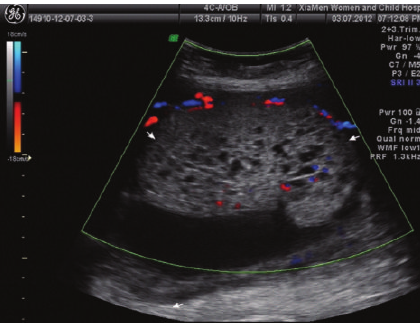
Figure 2: Placenta with multiple cystic echoes (such as moth-eaten appearance) without vascular flow.